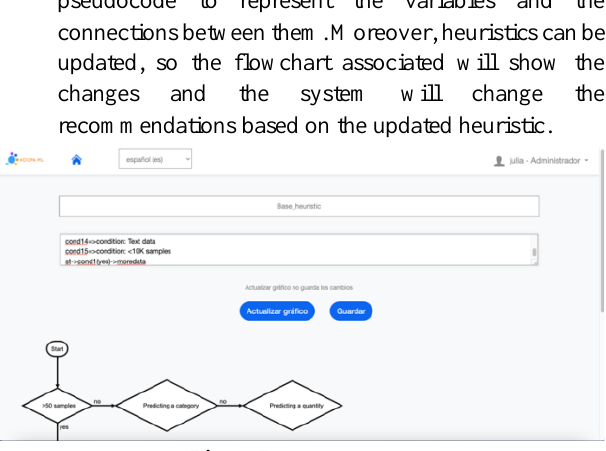
Figure 7. Heuristic editor.